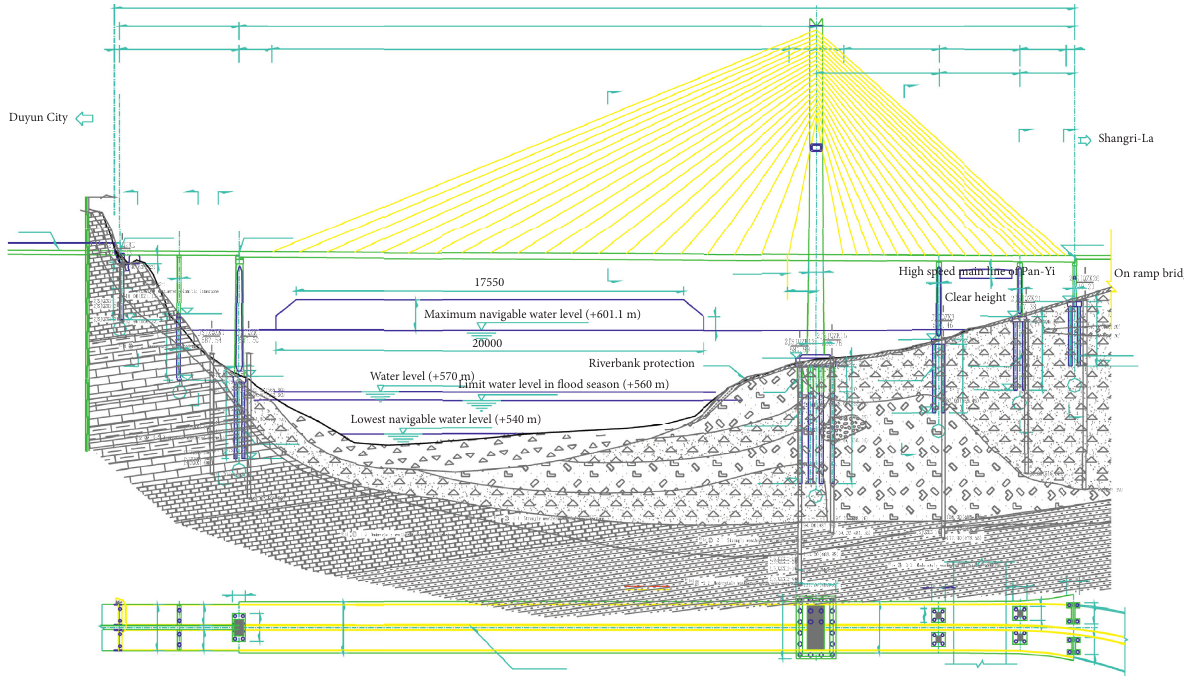
Figure 1: The layout of Jinsha River